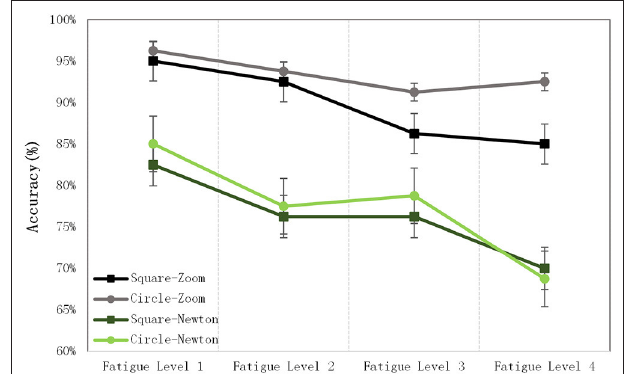
FIGURE 9 | Recognition accuracy for different fatigue levels.